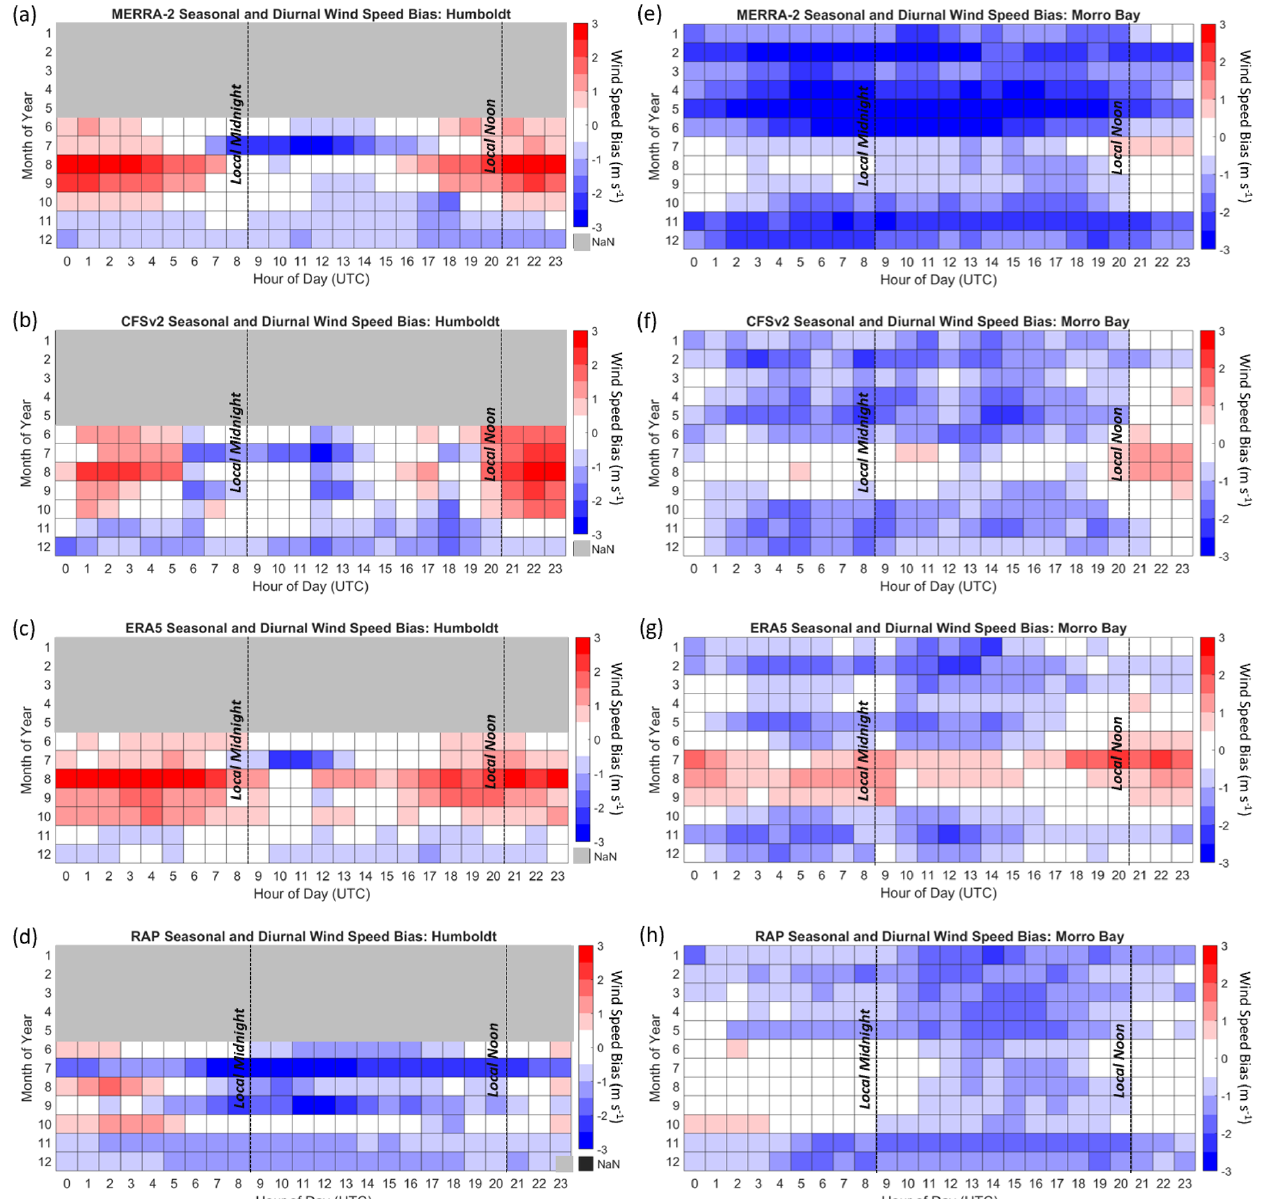
Figure 12. Seasonal and diurnal wind speed bias when comparing (a,e) MERRA-2 and observations at 50m, (b,f) the CFSv2 lowest 0– 30mbar layer above sea level and observations at 80m, (c,g) ERA5 and observations at 100m, and (d,h) RAP and observations at 80m at Humboldt and Morro